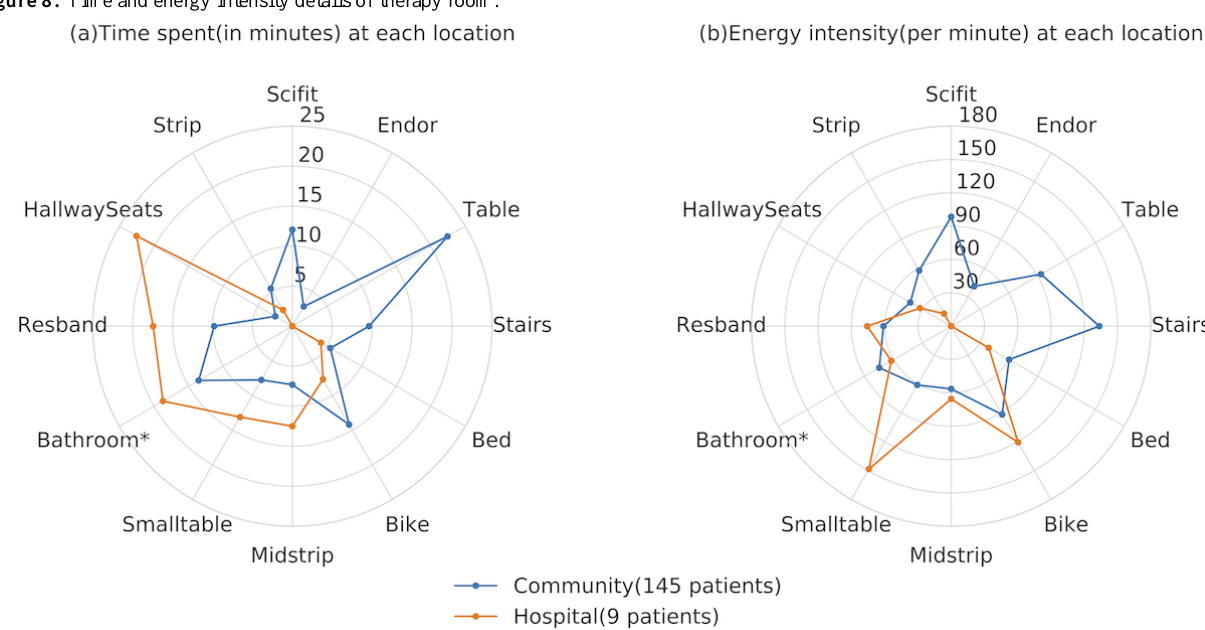
Figure 8. Time and energy intensity details of therapy